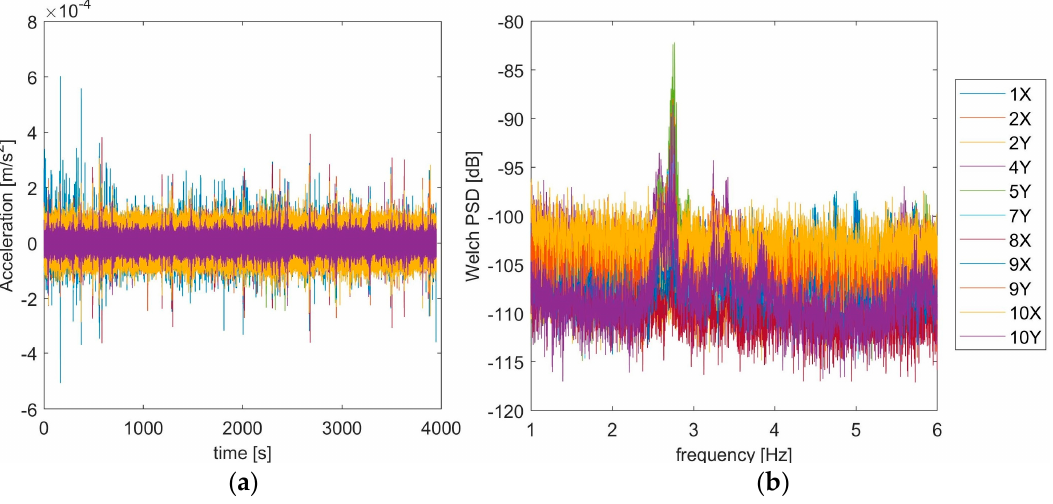
Figure 11. Measured acceleration responses: ( a ) time − domain; ( b ) frequency − domain.